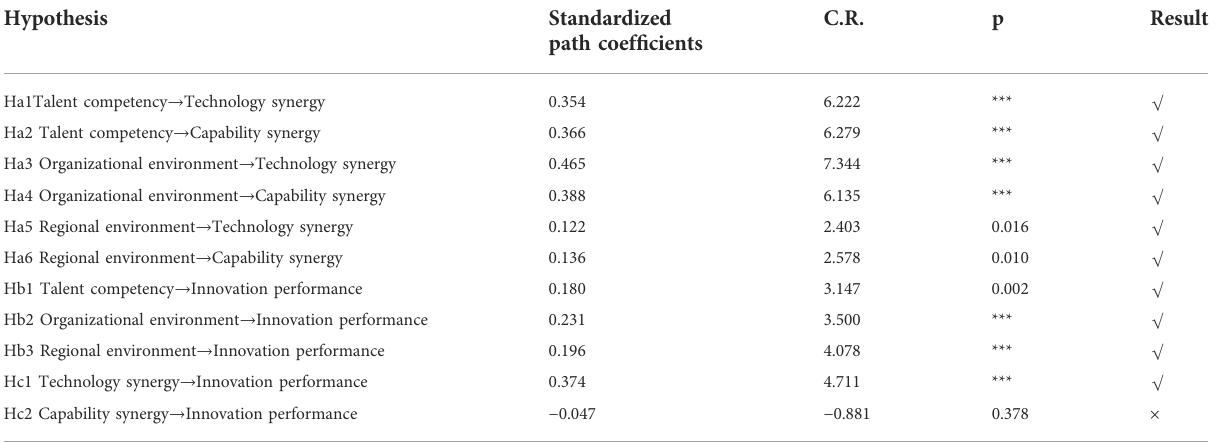
TABLE 4 Results of structural equation model path coef fi cients and hypothesis